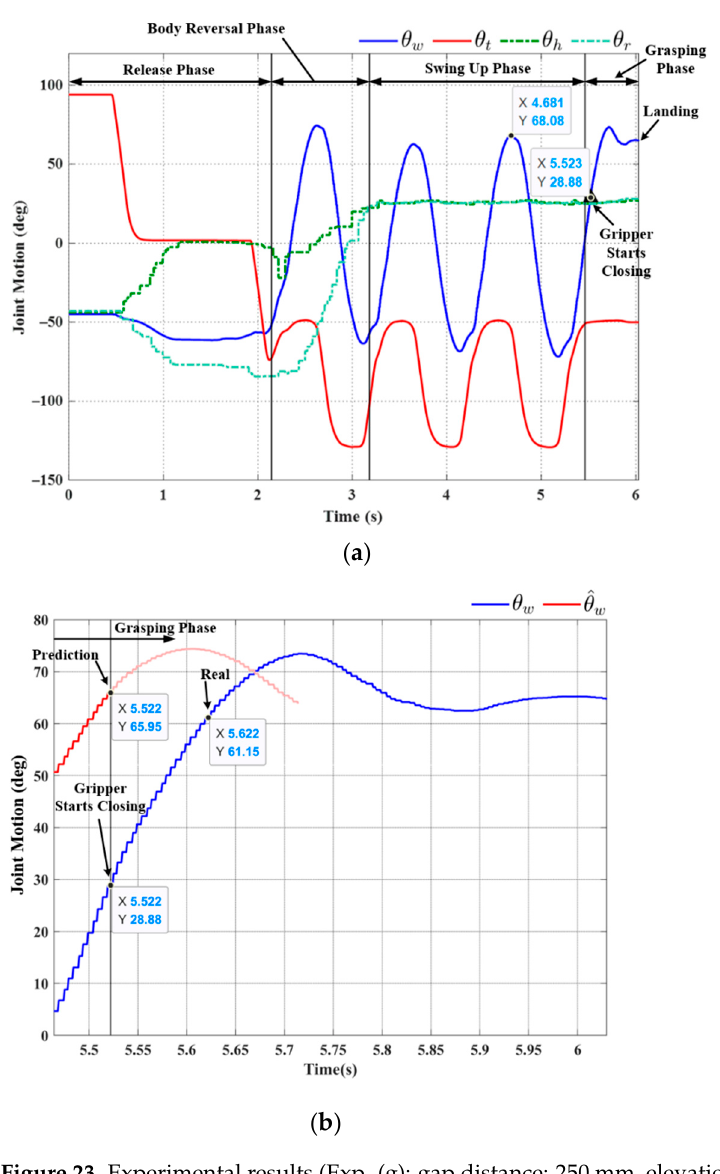
Figure 23. Experimental results (Exp. (g): gap distance: 250 mm, elevation: 0 mm): ( a ) joint motion; ( b ) predicted wrist joint motion and gripper command timing.